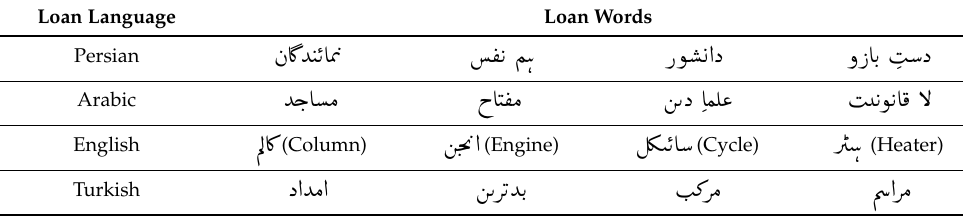
Table 4. A few examples of load words used in the Urdu